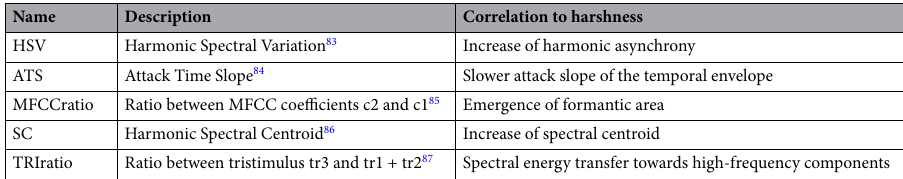
Table 2. Acoustic descriptors used in the study and their correlation to the perceived harshness